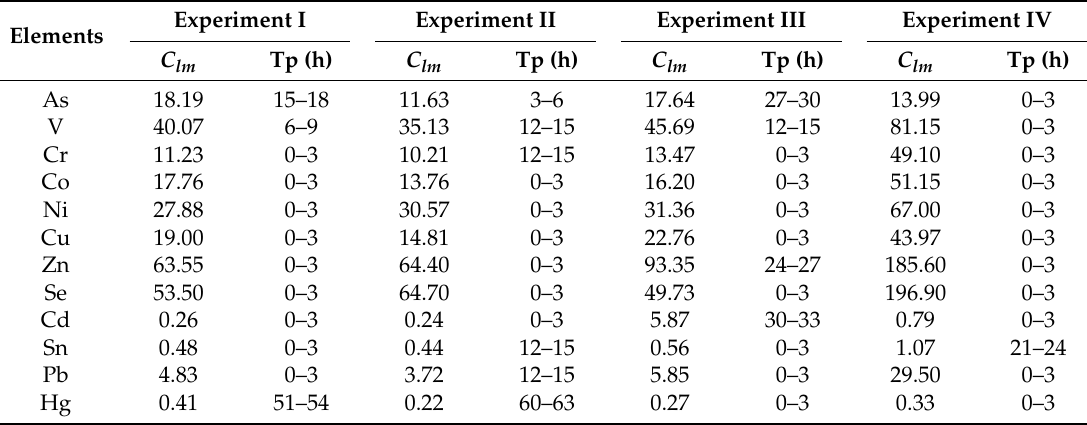
Table 8. The maximum leached concentrations ( C lm ) of the 12 elements from the coal gangue of the Wulantuga open-cast coal mine area ( µ